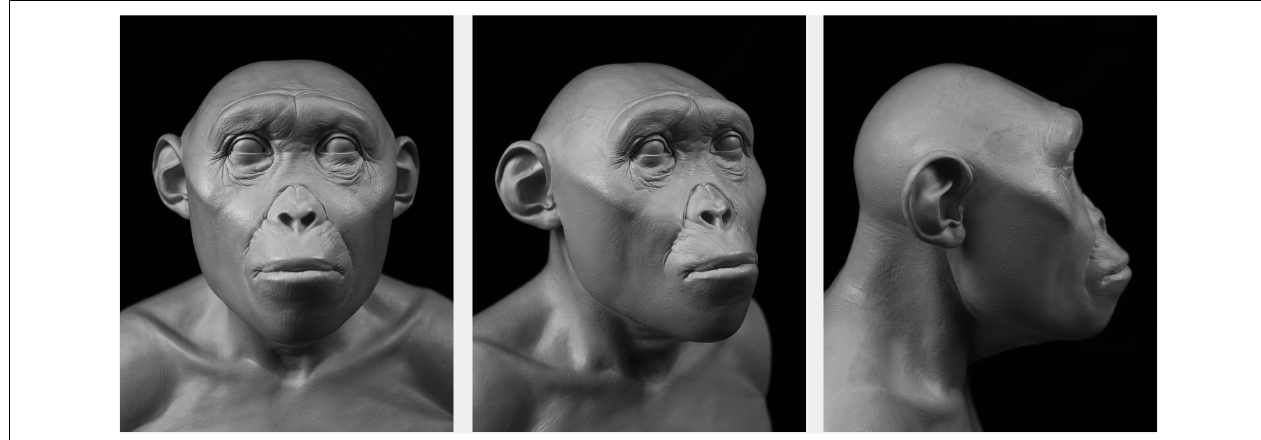
FIGURE 4 | A facial reconstruction of Lucy (without hair and pigment) produced in 2019 that employed facial soft tissue regression models developed in Simpson and Henneberg (2002) from modern human